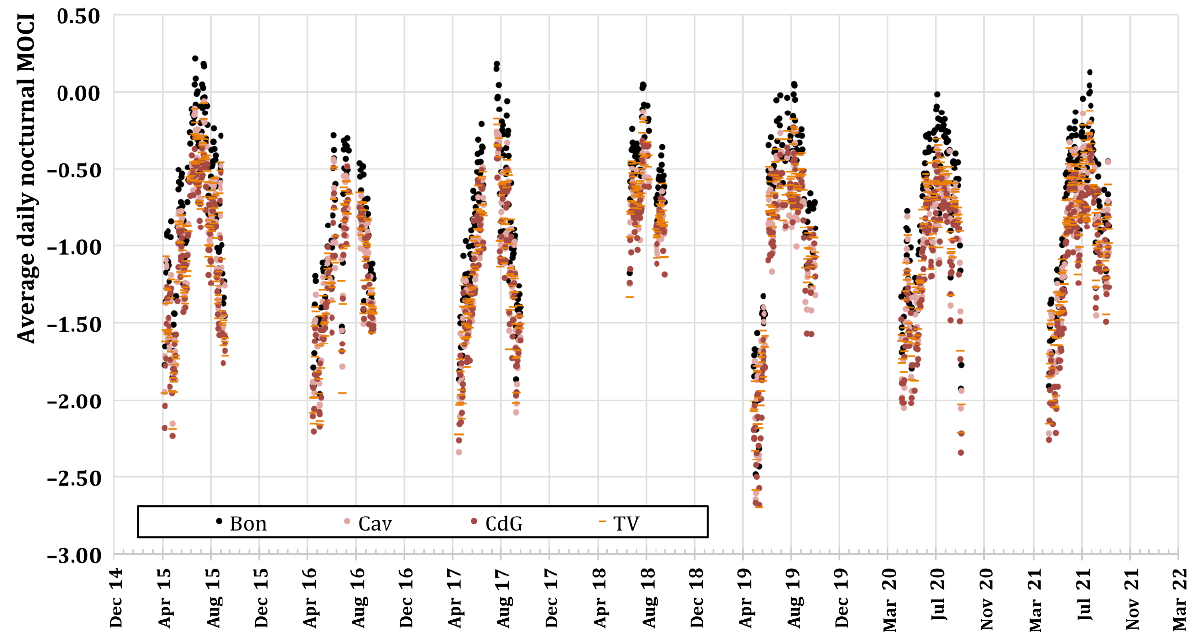
Figure 3. Time series of daily ‐ averaged nocturnal (from 20:00 to 05:00 LT) MOCI index for the four ARPA stations.